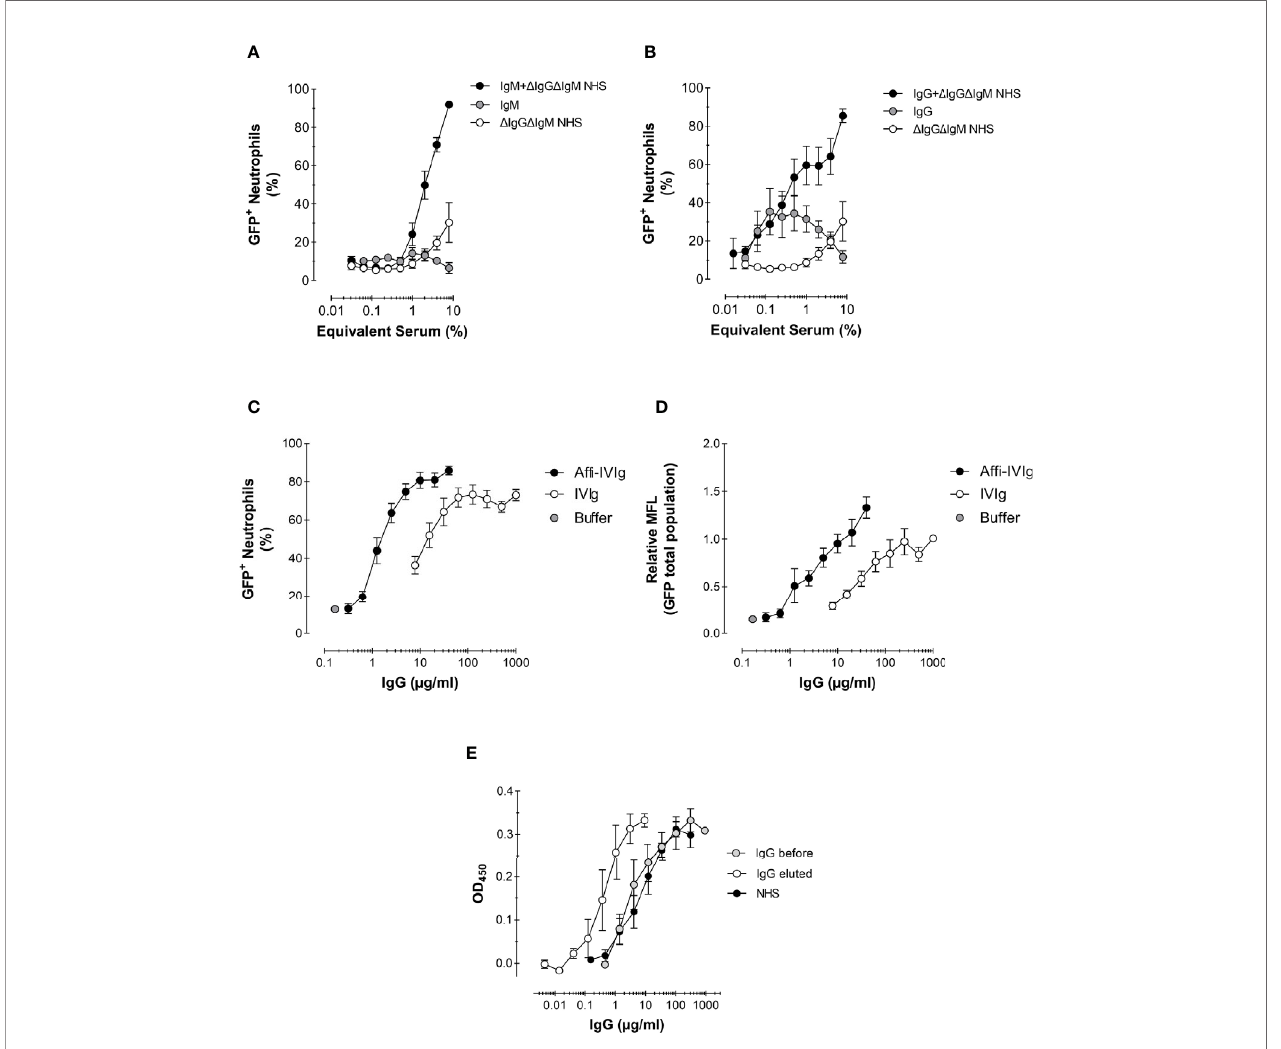
FIGURE 4 | Role of antibodies and complement in the phagocytosis of S. aureus. (A, B) Phagocytosis expressed as percentage of GFP+ neutrophils of Newman D SpA D Sbi opsonized with a complement source depleted of antibodies ( D IgG D IgM NHS), NHS-puri fi ed IgM (A) or IgG (B) , or the combination of IgM (A) or IgG (B) reconstituted with complement. For puri fi ed IgM the equivalent concentration present in 8% serum is used, 120 µg/ml (A) , and for puri fi ed IgG that is 1,000 µg/ml (B) ; these concentrations were also used to reconstitute into 8% D IgG D IgM NHS. Data represent Mean ± SEM for n=2 – 8. (C, D) Phagocytosis of S. aureus KV27 opsonized with either commercial IgGs for intravenous use (IVIg), or the same IgGs af fi nity puri fi ed on a S. aureus Newman D SpA D Sbi column (Af fi - IVIg). Phagocytosis is expressed as the % of GFP+ neutrophils per increasing percentage of IVIgs or Af fi -IVIgs. Mean ± SEM for n=7 (C) and as the Mean Fluorescence (MFL) of the total neutrophils engul fi ng GFP-expressing bacteria (D) . Mean ± SEM for n=6. (E) Binding speci fi city of NHS, IVIg (IgG total) and Af fi -IVIg (IgG eluted) antibodies assessed by ELISA, using S. aureus strain Newman D SpA D Sbi. Mean ± SD for n =